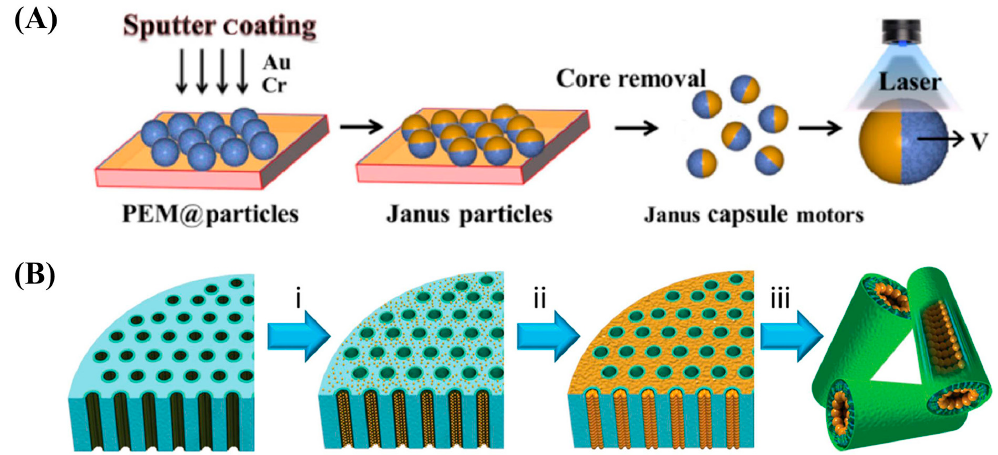
Figure 6. Schematic illustration of MNMs fabricated by the LbL method. ( A ) Scheme of light-triggered Janus capsule motors. Reproduced with permission [90]. Copyright 2014, American Chemical Society; ( B ) Illustration of the fabrication of tubular rockets: (i) LbL assembly of (PAH/PSS) 20 films, and subsequent deposition of AuNPs into the pores of templates; (ii) Formation of AuNSs though surface-seeding growth method; (iii) Removal of the templates to release the rockets. Reproduced with permission [92]. Copyright 2015, Wiley-VCH.